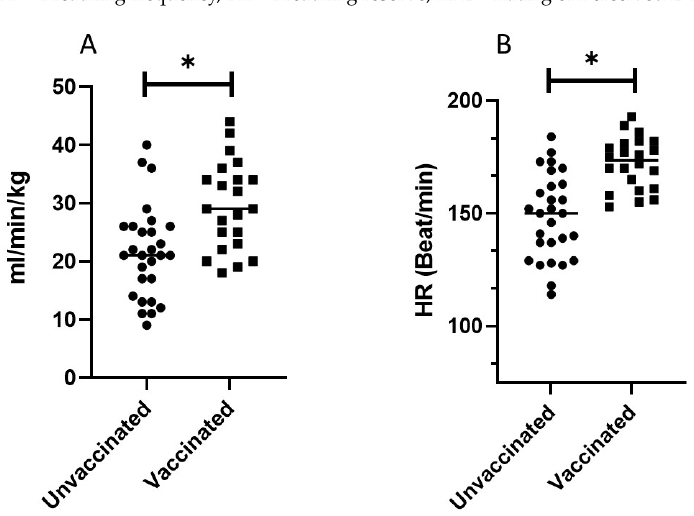
Figure 1. VO 2 /kg peak ( A ) and peak heart rate ( B ) among COVID-19 unvaccinated vs. vaccinated patients previously infected with SARS-CoV-2 (* p <